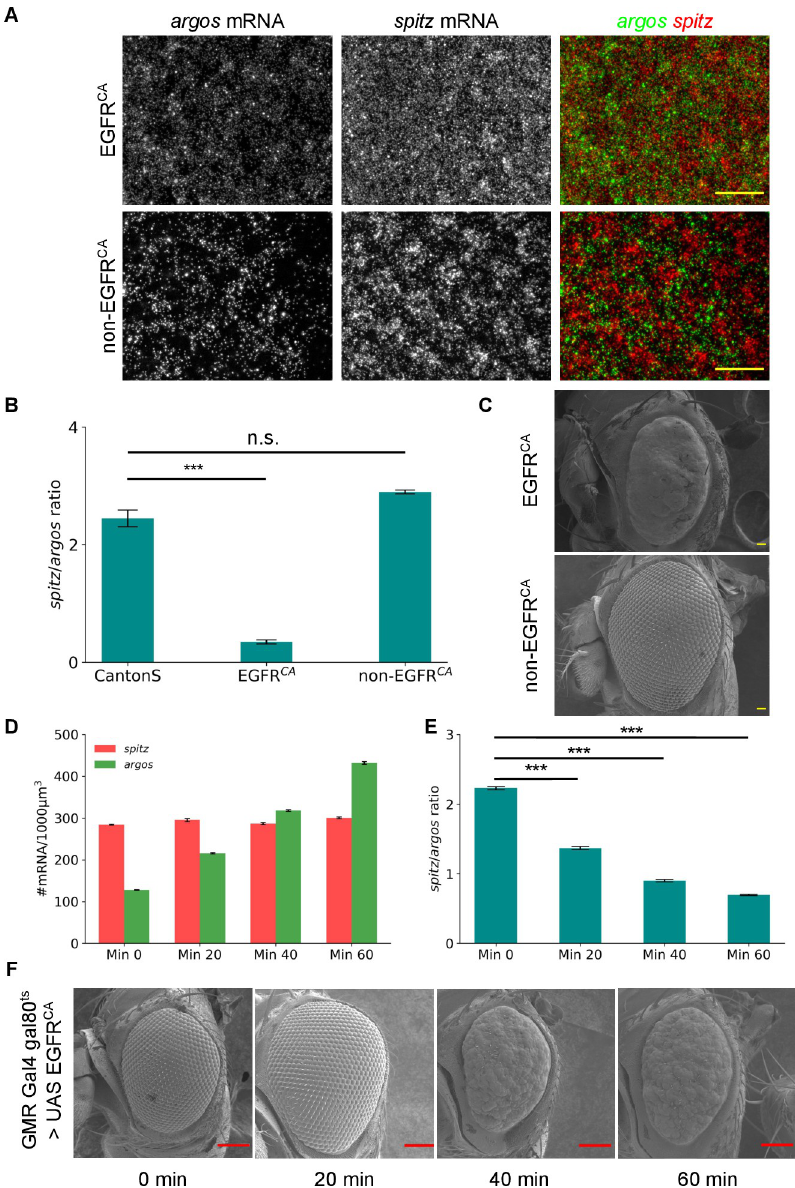
Fig 3. Overexpression of EGFR completely disrupts ommatidial pattern from the adult eye. (A) Eye imaginal discs of GMR > UAS EGFR CA progeny stained for spitz and argos mRNA. From the same cross, EGFR CA and non-EGFR CA larvae were distinguished using the balancer phenotype. Scale bar for widefield images is 10 μ m. Exclusive expression of spitz and argos is lost in EGFR CA which leads to change in the spitz -to- argos ratio represented in (B) [CantonS N = 9, EGFR CA N = 10, non-EGFR CA N = 9] (p-values from a Student’s t-test; ��� = < 0.001, n.s. = > 0.05). (C) 170X SEM images of GMR > UAS EGFR CA progeny. The ommatidial pattern is lost when EGFR is constitutively active and the size of the eye is also reduced. Heatshock was administered for 6 hrs to EGFR CA and non-EGFR CA larvae for maximal activation of the cassette. Scale bar is 10 μ m. (D) Absolute spitz and argos mRNA numbers from Gal80 ts ; GMR-Gal4 > UAS EGFR CA progeny after different timepoints of heatshock at 29˚C. N = 8 for all time points. (E) spitz -to- argos ratios in eye discs corresponding to different time points of heat shock at 29˚C. Quantification of absolute mRNA numbers and ratios represented in all the above plots were calculated in the eye field irrespective of the cell type. Error bars in all the plots are standard errors of mean. The change in spitz -to- argos ratio with heatshock is significantly different irrespective of timepoints when compared with no-heatshock control (p-values < 0.001 ( ��� ) in a Student’s t-test). (F) Adult eyes corresponding to different time points of heat shock at 29˚C. Scale bar is 100 μ m. No rough eye phenotype is seen for 20 min of heatshock, though a difference in the spitz -to- argos ratio is already seen at this point. Beyond this the eyes are fully rough, and the phenotype is fully penetrant. This is indicative